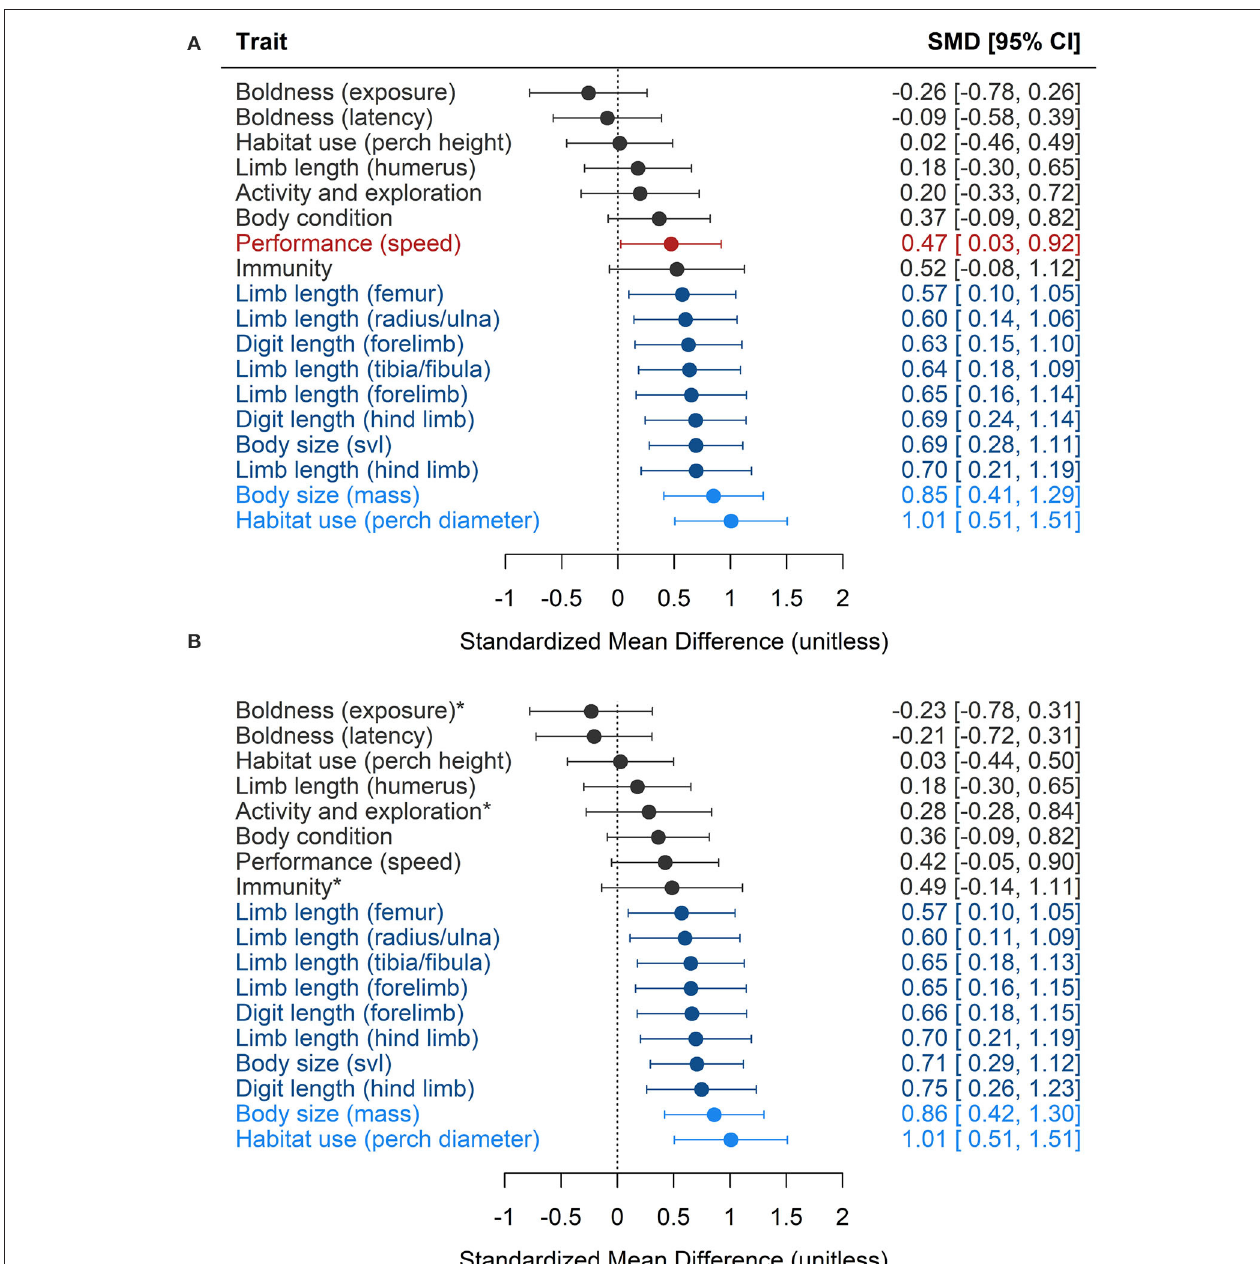
FIGURE 5 | The effect of urbanization on lizard phenotypic traits in (A) the full model with all recorded effect sizes ( n = 348), and (B) the reduced model with pseudoreplicated effect sizes removed ( n = 274). Significant results are shown in blue (dark blue indicating medium effects, SMD > 0.5, and light blue indicating large effects, SMD > 0.8) and error bars represent 95% confidence intervals. One trait, running performance, is highlighted in red as it reached significance in the full model, but not in the reduced model. Traits in the reduced model that failed to meet the minimum sample size of 10 effect sizes are indicated with asterisks. Snout-vent-length, a measure of lizard body length, is abbreviated to